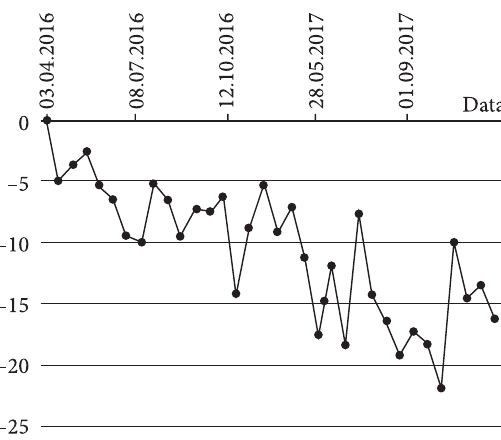
Figure 4. Dynamics of the vertical displacement at the point No. 1